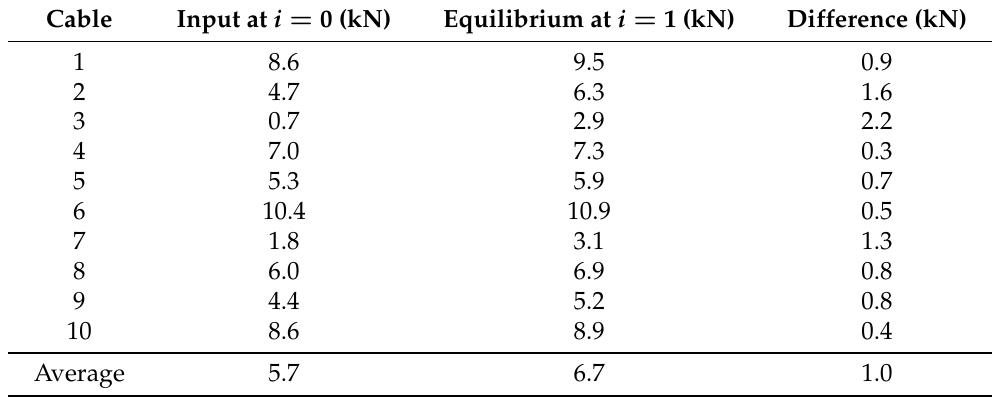
Table 10. Prestress in supporting cables: target level ( i = 0) and practical equilibrium state ( i = 1).